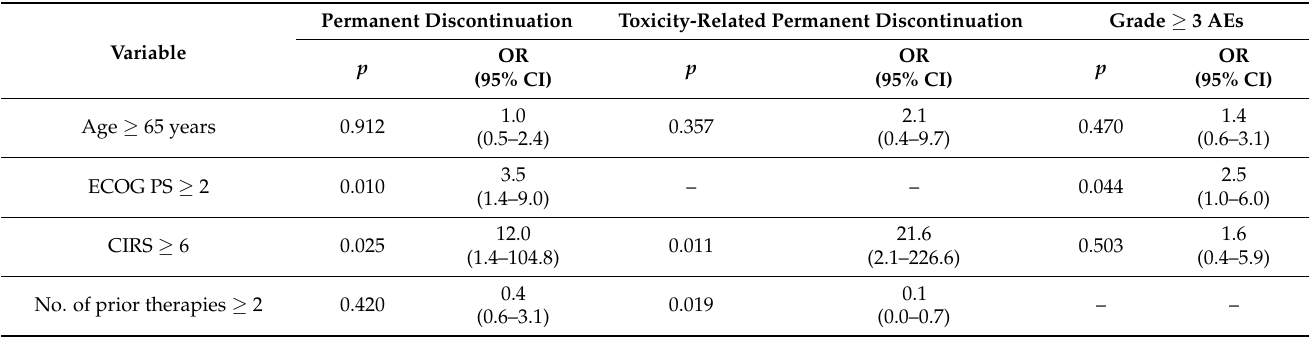
Table 7. Multivariate * logistic regression analysis showing the baseline factors associated